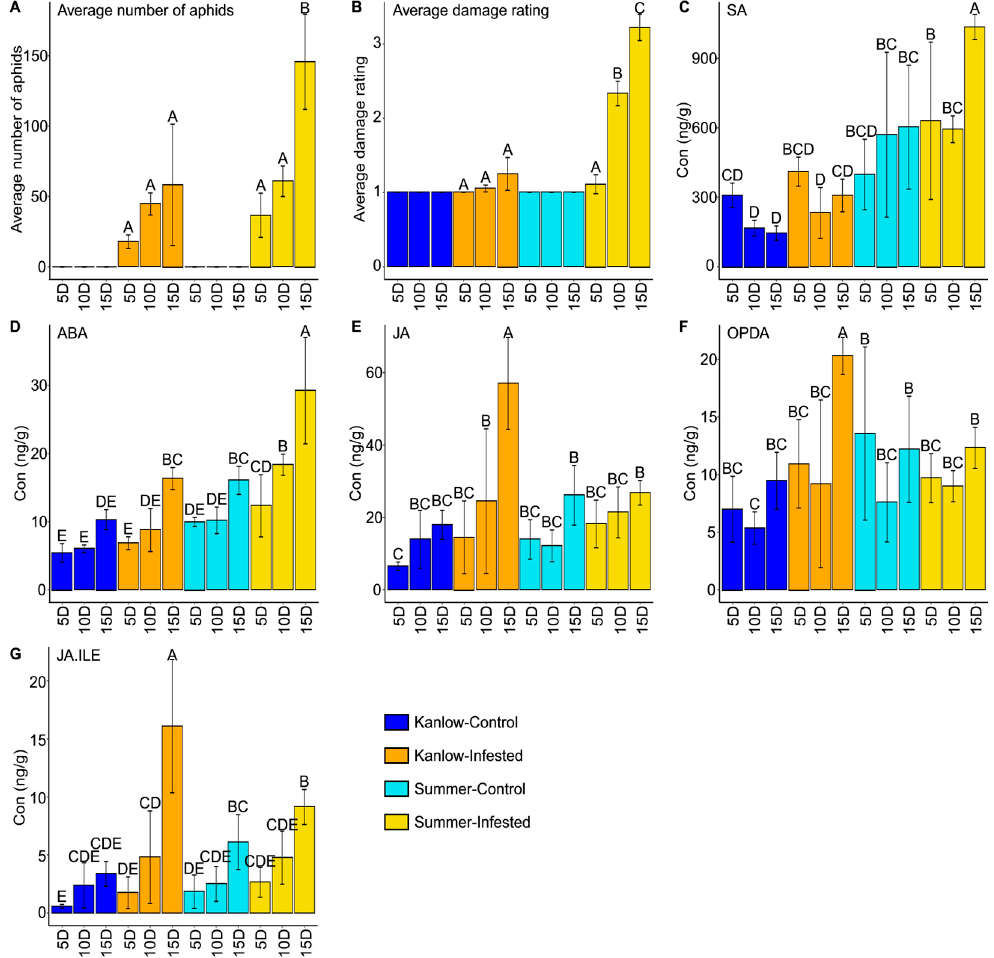
Aphid numbers, damage rating, and phytohormone levels. ( A ) Aphid numbers, ( B ) Plant damage ratings, ( C ) Salicylic acid (SA), ( D ) Abscisic acid (ABA), ( E ) Jasmonic acid (JA), ( F ) 12-Oxo-phytodienoic acid (OPDA), ( G ) Jasmonic acid-isoleucine (JA-Ile). Blue bars are for Kanlow control plants, orange bars are for aphid-infested Kanlow plants, turquoise bars are for Summer control plants, and gold for aphid-infested Summer plants. The letters indicate a significant di ff erence at p -value < 0.05, with separation of means using Fisher’s Least Significant Di ff erence (LSD). Error bars represent standard deviation.